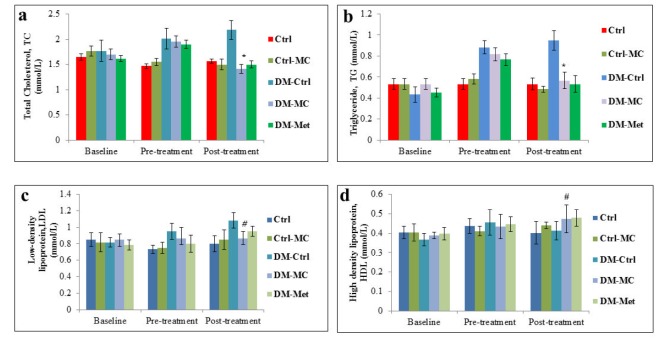
Effect of MC fruit extract on the fasting serum lipid profile of Sprague-Dawley rats. *Indicates a significant decrease (P<0.05) in a(TC) and b(TG) levels of the DM-MC group compared to the DM-Ctrl group. # Indicates no significant difference (P>0.05) in c(LDL) and d(HDL) levels.